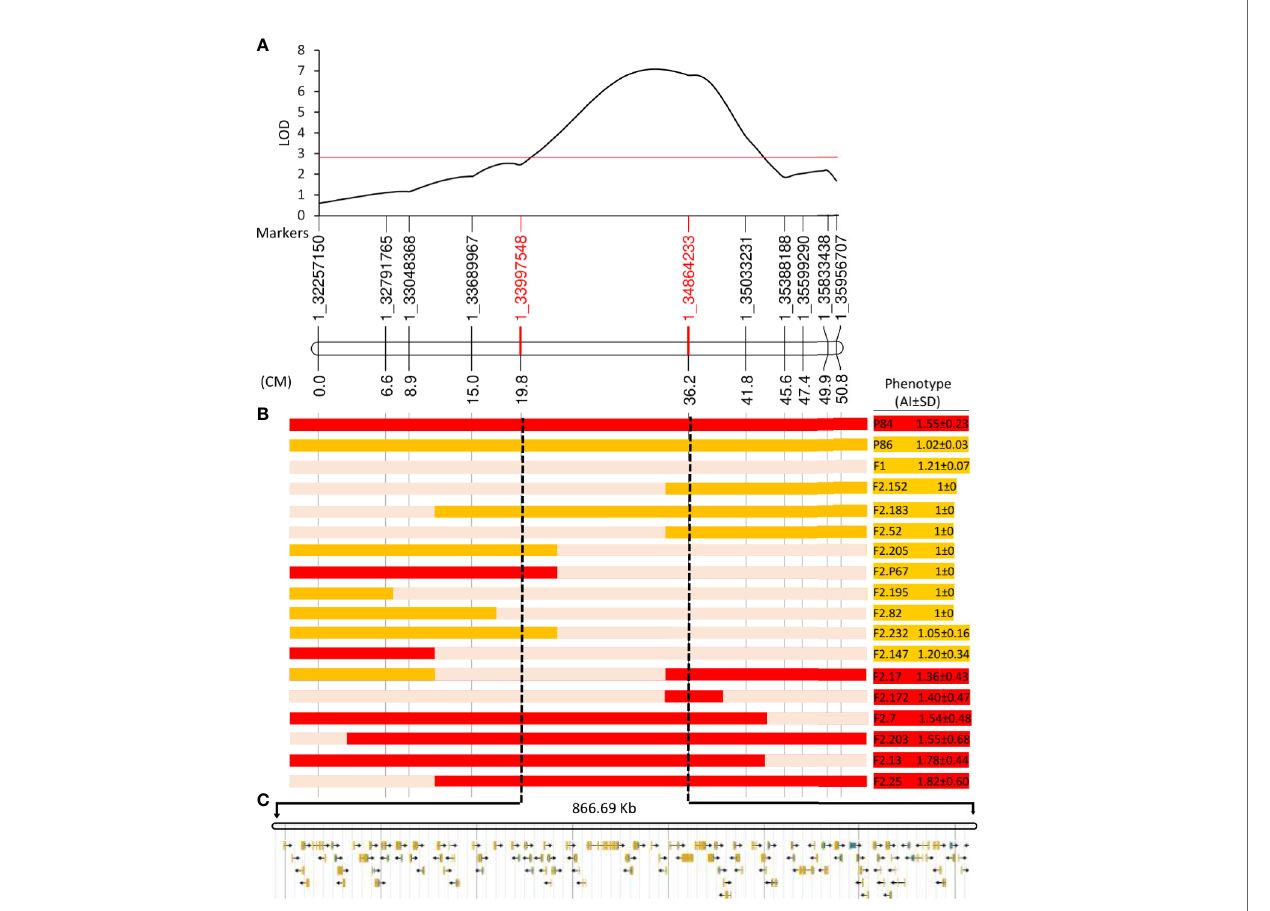
FIGURE 5 | Fine mapping of partial andromonoecy ( pa ) locus. (A) Interval mapping result on chromosome 1, showing the logarithm of the odds (LOD) score (y- axis), and the genetic distances for the 11 SNPs (x-axis) that were used. The numbers of the markers correspond to their genomic position in bp. (B) Genotypes and Phenotypes of parents, F1, and 15 F2 informative individuals showing recombination in this genomic interval. The color bars show the genotypes along chromosome 1: red, homozygous for P84 allele (partially andromonoecious); orange, homozygous for the P86 allele (monoecious); light pink, heterozygous. The phenotypes for the andromonoecy index (AI) are shown on the right: red; partial andromonoecious (1.35<AI<2.7); orange, monoecious (1 ≤ AI ≤ 1.35). (C) The pa locus maps on an interval of 866.69 Kb between markers 1_3399758 and 1_34864233, which contains 101 annotated